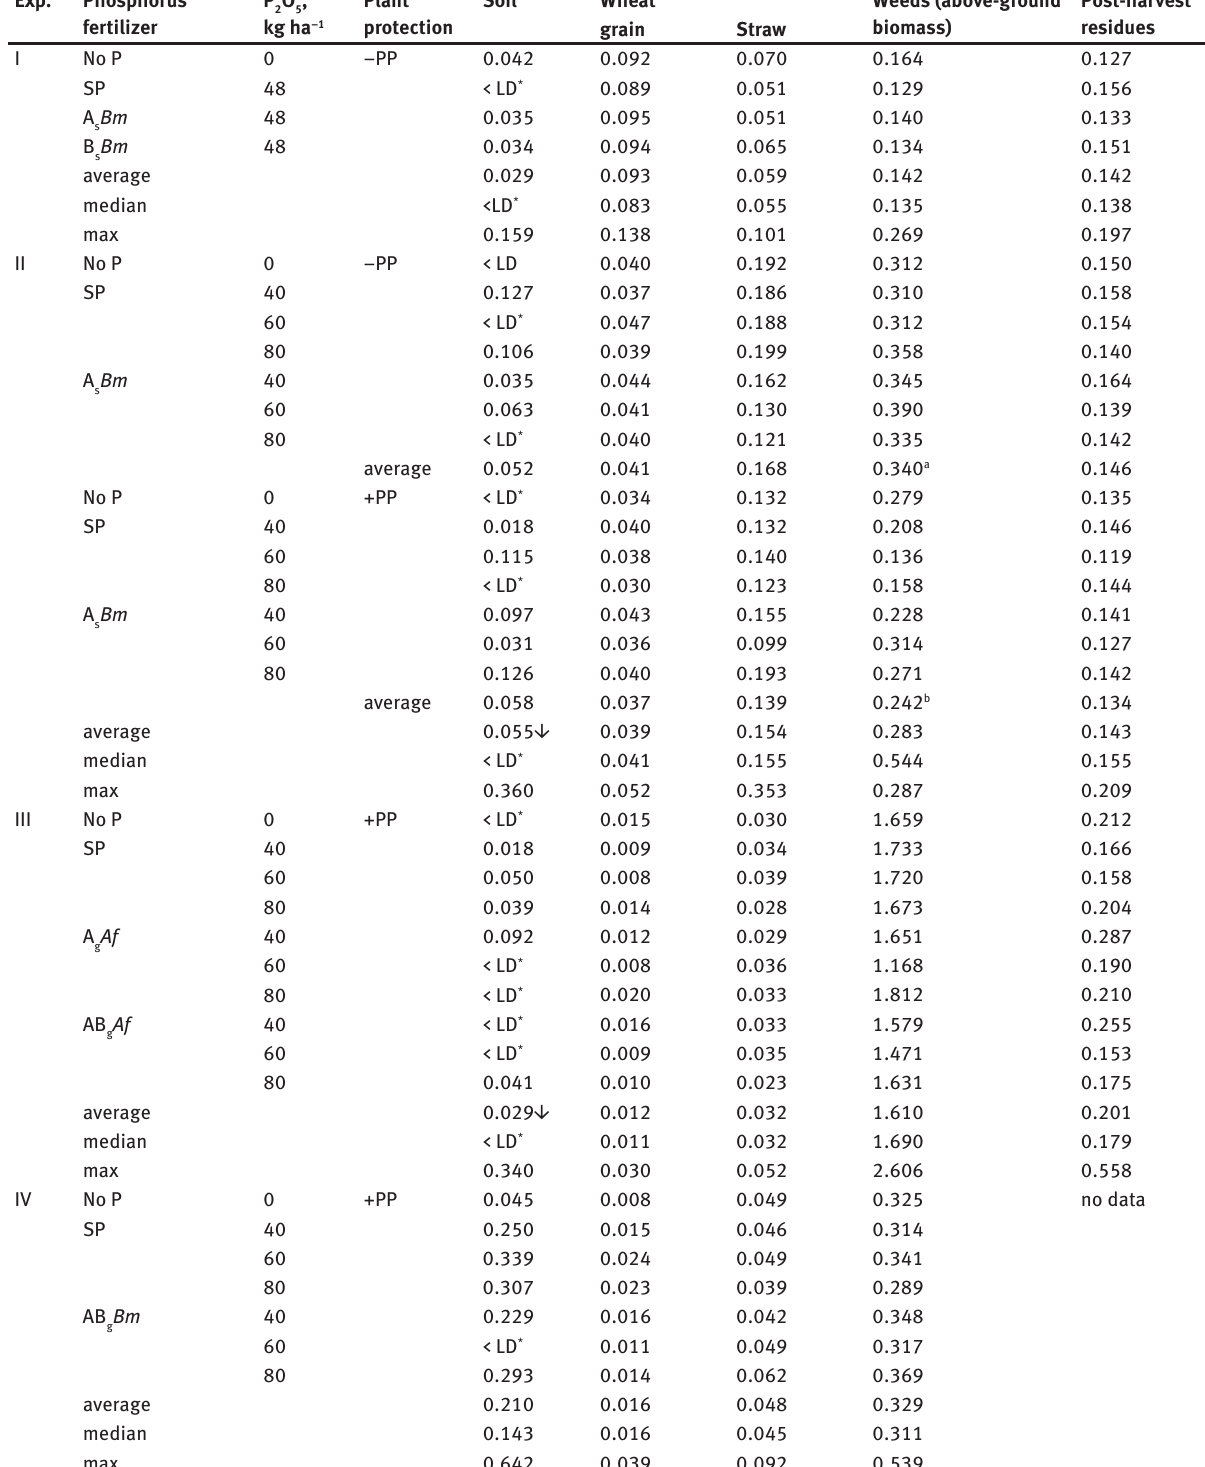
Table 7: Cadmium content in soil and plant biomass from wheat field, mg kg –1 (dry matter).